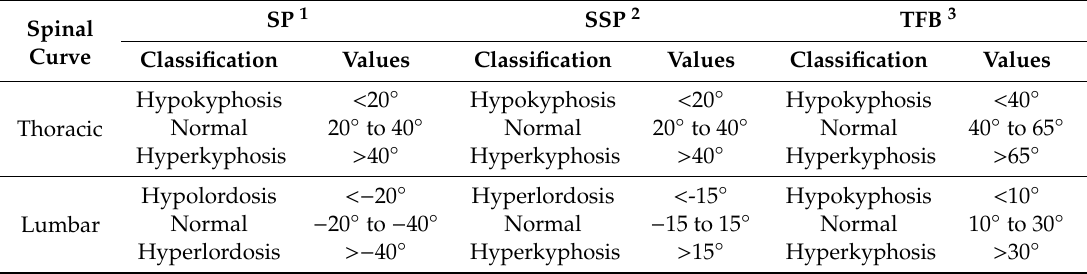
Table 1. Values of normality for thoracic and lumbar curves in each position [49,51].